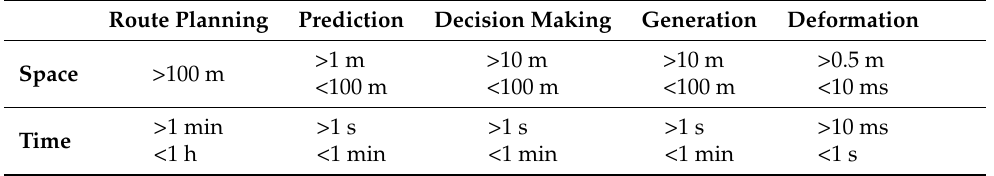
Table 1. Space and Time Horizon for the Autonomous Driving